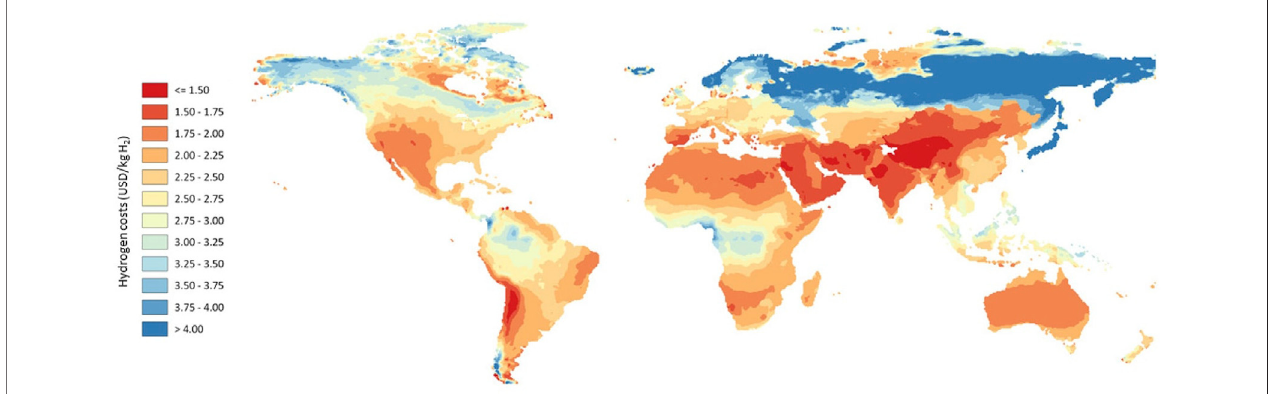
FIGURE 1 | Hydrogen production cost from hybrid solar PV and wind systems in